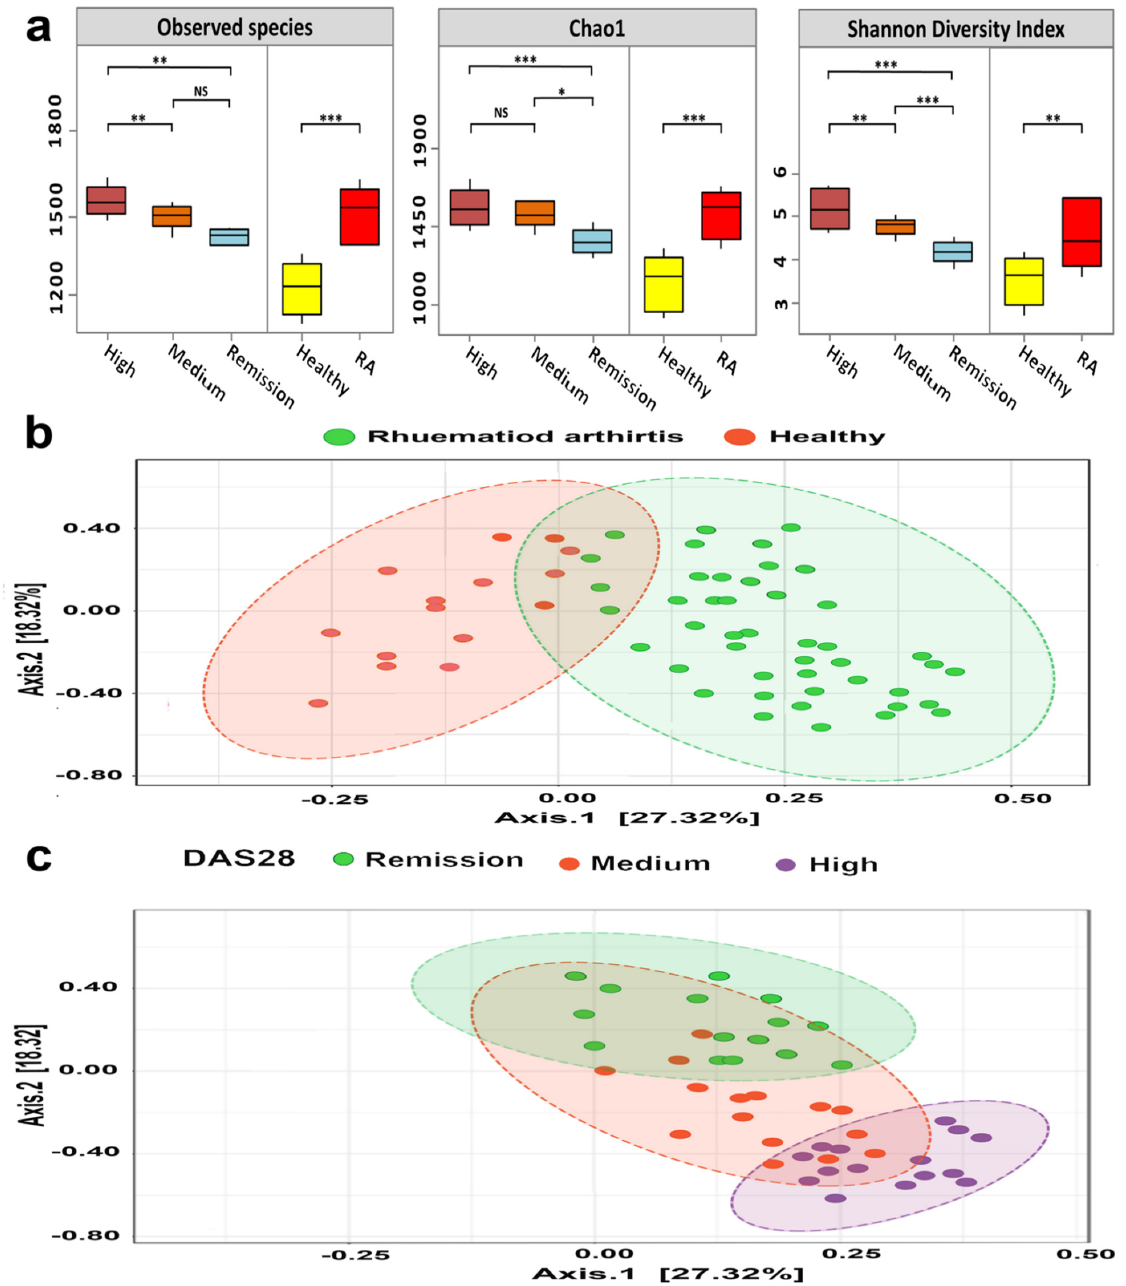
Figure 2. Bacterial diversity analysis of gut microbiomes. ( a ) Alpha diversity of gut microbiomes. Box plots define the bacterial diversity in terms of richness: the number of observed species and Chao1 index, and evenness; Shannon diversity index. The X-axis denotes the study groups, and the Y-axis shows the alpha diversity indices. The line in each box represents the median, the box delimits the interquartile range (IQR) between the 25th and 75th percentile, and the range was indicated by the whisker. The nonparametric Wilcoxon rank-sum test was performed to define the statistical significance of pairwise comparisons. Only significant differences were displayed with either * ( p < 0.05), ** ( p < 0.01) or *** ( p < 0.001). Interindividual divergence of gut microbiomes (beta diversity) was shown in b and c. Similarity distances between either healthy and RA microbiomes ( b ) or between RA bacterial communities ( c ) were represented by Principal coordinates analysis plots (PCoA) of gut microbiomes that were based on weighted UniFrac matrices. The significance of clustering was indicated by eclipses.